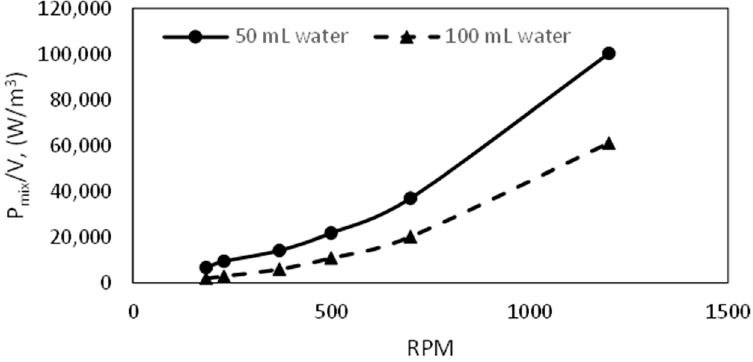
Figure 14. Power input per unit volume of water at different water content in a 141.4 mL cell at 6 °C bath temperature.